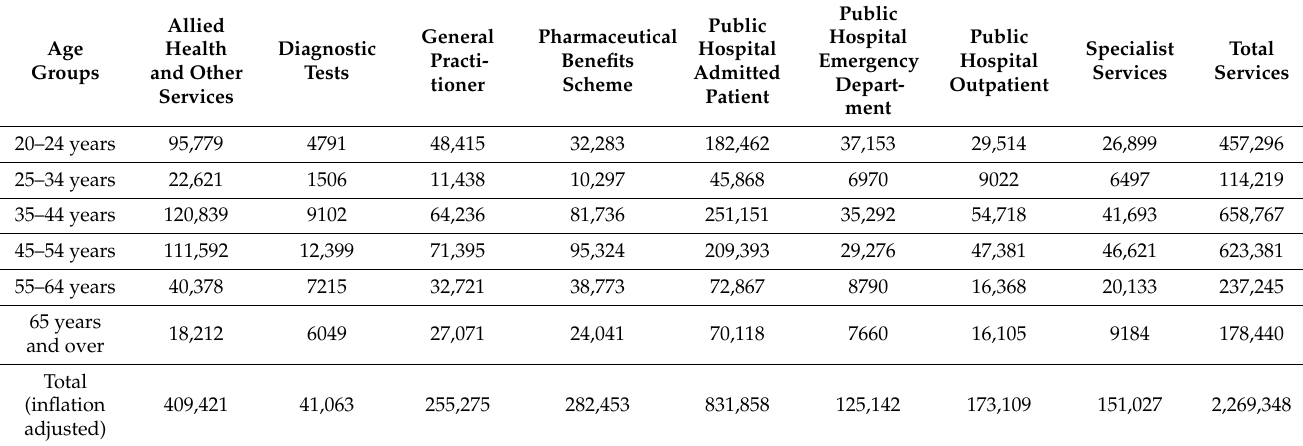
Table A3. Extra costs incurred due to LHL for people diagnosed with Mental illness the Blacktown LGA (Domain 6).